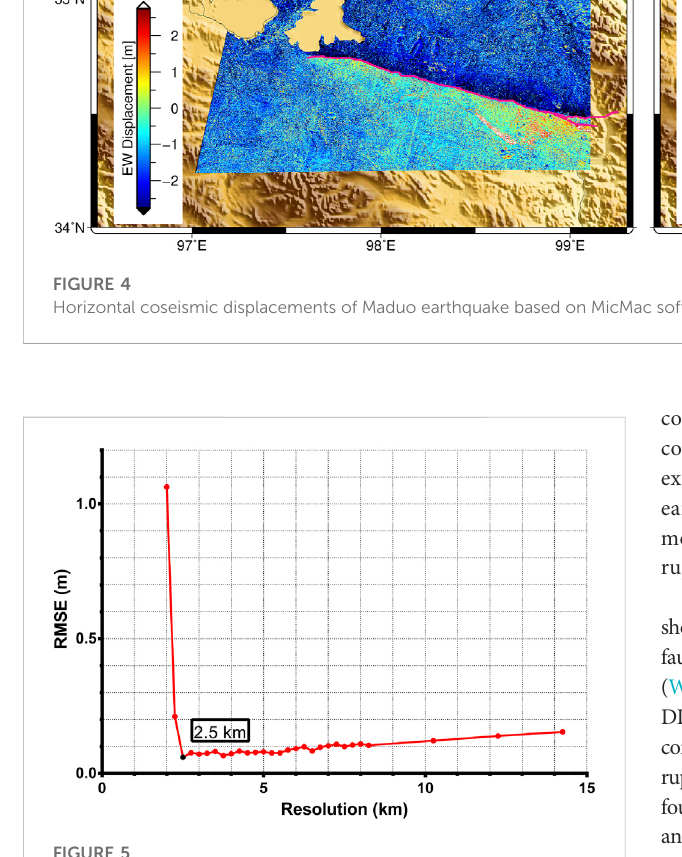
Figure 6. Due to the limited spatial coverage of Sentinel-2 images, the resolved 3D displacements have a smaller spatial size that is zone. Obviously, the ground surface movement of the 2021 Mw 7.4 Maduo earthquake is dominated by the EW displacements, which are in a range of -2m ~ 2 m. The NS displacement is much smaller (ranging from -0.8m – 0.8 m), which also seems not